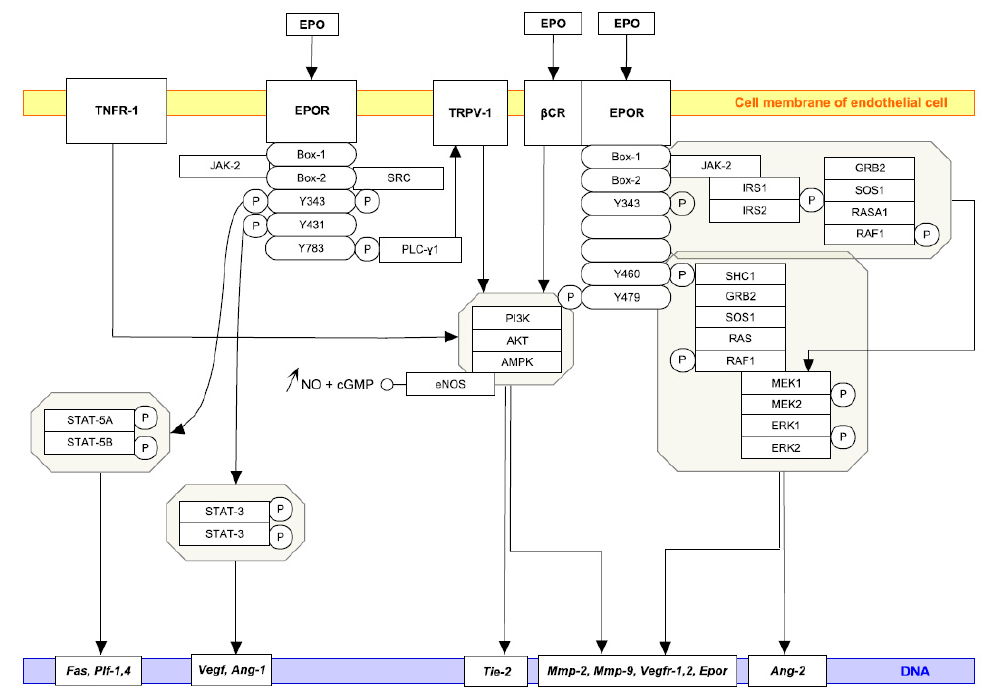
Figure 1. EPO and the signalization of ECs. EPO-induced signalization of EC along with target genes associated with angiogenesis are outlined. Docking sites for several signaling proteins are marked with P; only positive interactions are presented with full black arrows. EPOR WikiPathway (Available on: http://www.wikipathways.org) was modified with PathVisio tool based on the references mentioned in the article.